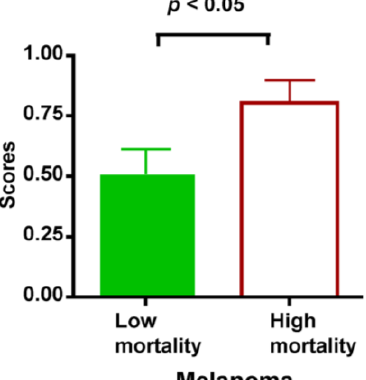
Figure 3. Biomarker scores can be used for the prognosis of melanoma. Serum samples from melanoma patients were tested for elevated levels of IL-8 and Cathepsin B. High mortality group: patients died within 3 years after enrollment of the study; Low mortality group: patients survived for more than 3 years after enrollment of the study. Patients were scored based on the initial serum levels of IL-8 and Cathepsin B. Patients receive 0 score for normal levels, 1 score for elevated levels of only one biomarker and 2 scores if both were elevated. Patients in the High mortality group showed significantly higher scores as judged by unpaired t test. Data were presented as mean ±